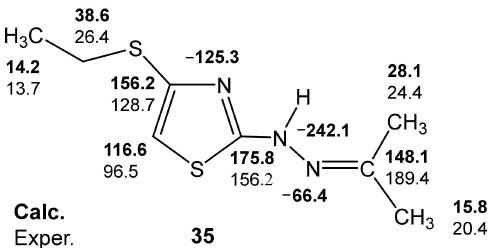
Figure 8. Calculated B3LYP/6-311++G(d,p) (GIAO) and experimental 13 C and 15 N NMR spectra of compound 35